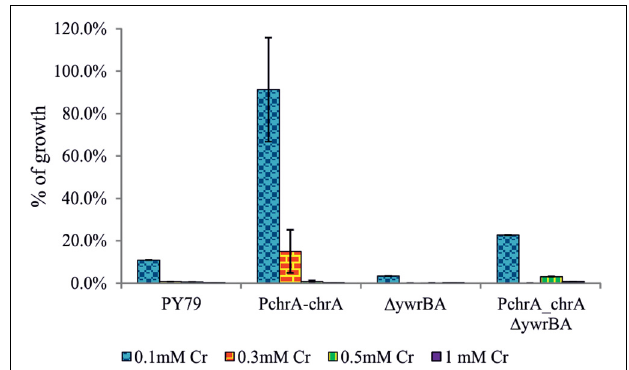
FIGURE 4 | The CFU outgrowth of strains after exposure to different levels of Cr stress. After 6 h of growth in M9 supplemented with Cr(VI), cultures were serially diluted and plated onto M9 agar media. CFU counts of strains affected by Cr stress were expressed as a percentage of CFU count of strains grown without Cr(VI). Different levels of Cr stress were represented by different concentrations of Cr(VI) in media. For each strain and Cr(VI) concentration, the experiment was performed at least in triplicate. In some cases, the standard error bars are too small to be